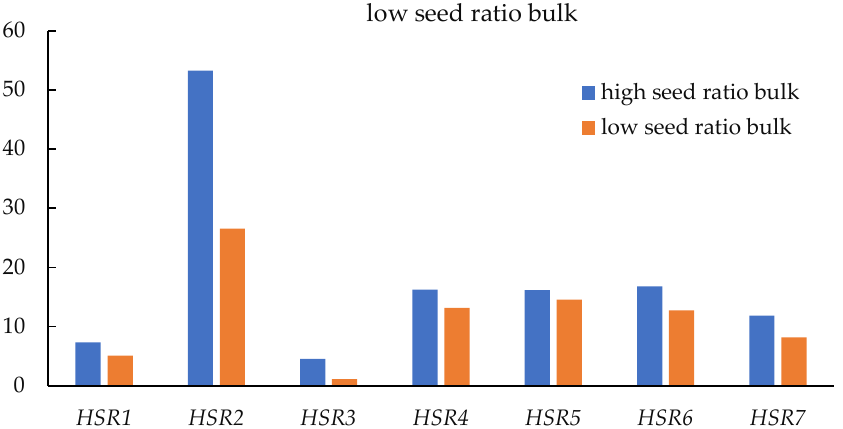
Figure 8. Analysis of the expression of genes associated with high seed ratio. HSR: high seed